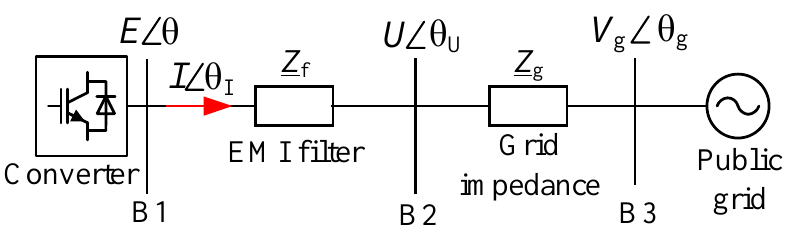
Figure 1. Single line diagram of the converter-grid system.